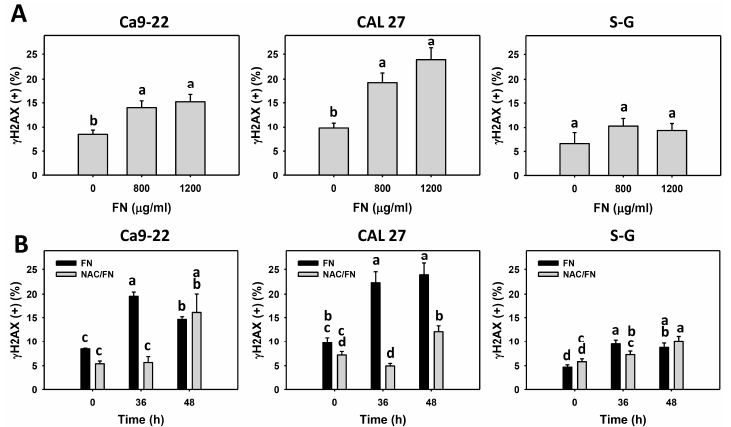
Figure 8. Fucoidan increases the γH2AX level of oral cancer cells. Summary histograms of the flow cytometry results are presented. The individual density plots are presented in Supplementary Fig- ure S3. ( A ) γH2AX statistical analysis. Oral cancer (Ca9-22 and CAL 27) and non-malignant cells (S– G) were treated with fucoidan (control, 800, and 1200 μg/mL) for 0 and 48 h. (+) indicates a high level of γH2AX. ( B ) The effect of oxidative stress on the γH2AX increment in fucoidan-incubated oral cancer cells. After NAC preincubation or not, cells were post-treated with fucoidan (1200 μg/mL) with NAC co-treatment (10 mM) for 0, 36, and 48 h. NAC/fucoidan (NAC/FN) represents pretreatment with NAC and post-treatment with FN. Data = mean ± SD ( n = 3 experiments). Data with non-overlapping letters reveal significant differences ( p < 0.05). In the example of Figure 8B (CAL 27 cells), FN at 0 and 36 h, labeled with the connecting letters “bc and a”, has significant re- sults, because the letters do not overlap. FN and NAC/FN at 36 or 48 h labeled with “a and d” and “a and b” have significant results. In contrast, FN at 36 and 48 h labeled with “a” has nonsignificant results because they overlap with “a”. The positive control of γH2AX is provided in Supplementary Figure S9. Figure 9. Fucoidan increases the 8-OHdG level of oral cancer cells. Summary histograms of the flow cytometry results are presented. The individual density plots are presented in Supplementary Fig- ure S4. ( A ) 8-OHdG statistical analysis. Oral cancer (Ca9-22 and CAL 27) and non-malignant cells (S–G) were treated with fucoidan (control, 800, and 1200 μg/mL) for 0 and 48 h. (+) indicates a high level of 8-OHdG. ( B ) The effect of oxidative stress on the 8-OHdG increment in fucoidan-incubated oral cancer cells. After NAC preincubation or not, cells were treated with fucoidan (1200 μg/mL) with NAC co-treatment (10 mM) for 0, 36, and 48 h. NAC/fucoidan (NAC/FN) represents the pre- treatment with NAC and post-treatment with FN. Data = mean ± SD ( n = 3 experiments). Data with non-overlapping letters reveal significant differences ( p < 0.05). In the example of Figure 9B (Ca9-22 cells), FN at 0 and 36 h, labeled with the connecting letters “c and a”, has significant results, because the letters do not overlap. FN and NAC/FN at 36 or 48 h labeled with “a and b” have significant results. In contrast, FN at 36 and 48 h labeled with “a” has nonsignificant results because they over- lap with “a”. The positive control of 8-OHdG is provided in Supplementary Figure S10.